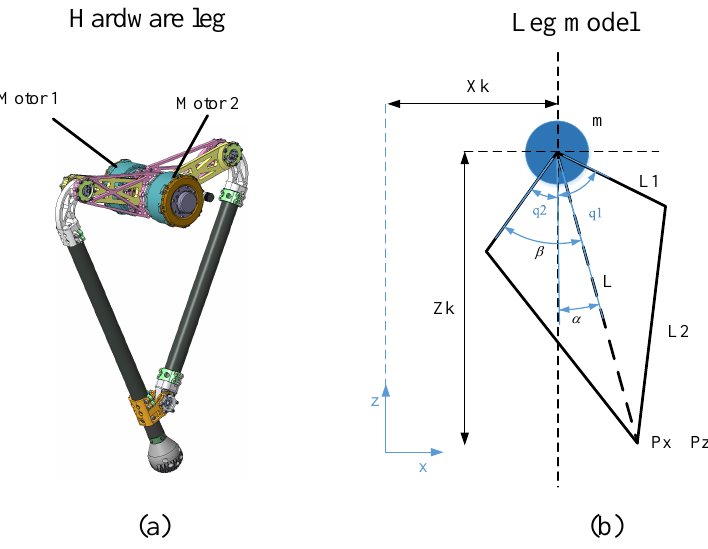
Figure 7. The leg model. ( a ) prototype of robot leg, ( b ) configuration